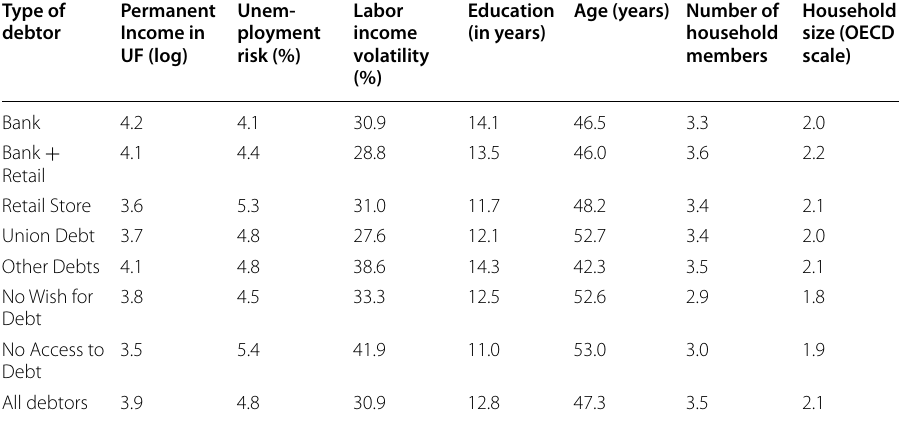
Table 5 Demographic characteristics of the households according to their debt type: average values per